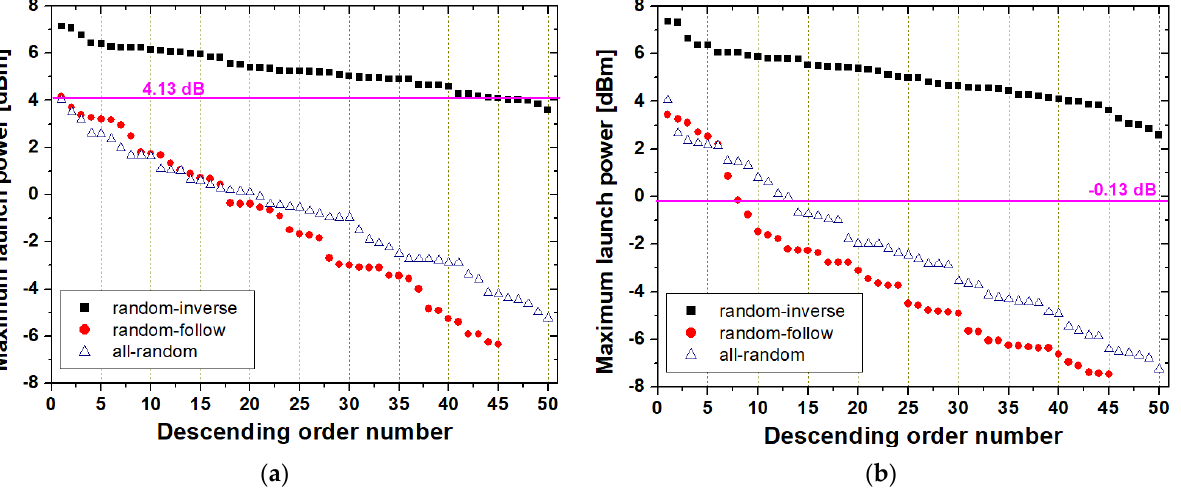
Figure 3. The maximum launch power of the worst channel. ( a ) Resulting 1-dB EOP, ( b ) resulting 2.5 ps timing jitter.